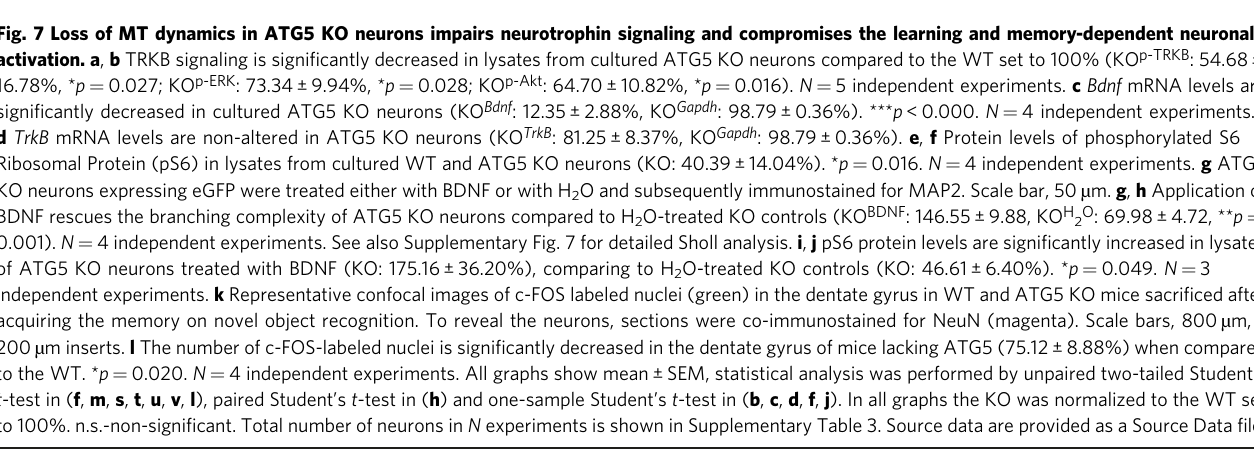
Fig. 7 Loss of MT dynamics in ATG5 KO neurons impairs neurotrophin signaling and compromises the learning and memory-dependent neuronal activation. a , b TRKB signaling is signi fi cantly decreased in lysates from cultured ATG5 KO neurons compared to the WT set to 100% (KO p-TRKB : 54.68 ± 16.78%, * p = 0.027; KO p-ERK : 73.34 ± 9.94%, * p = 0.028; KO p-Akt : 64.70± 10.82%, * p = 0.016). N = 5 independent experiments. c Bdnf mRNA levels are signi fi cantly decreased in cultured ATG5 KO neurons (KO Bdnf : 12.35 ± 2.88%, KO Gapdh : 98.79 ± 0.36%). *** p < 0.000. N = 4 independent